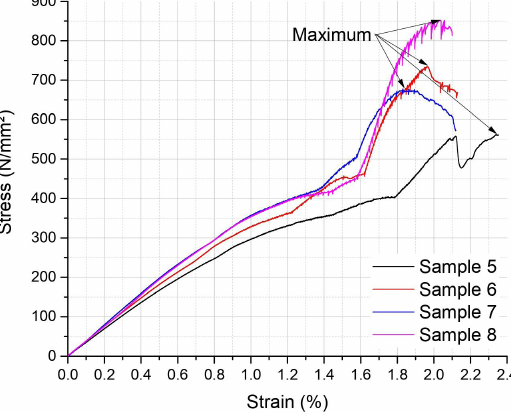
Figure 9. Flexure results of FRP-G laminates (Samples 5 to 8).